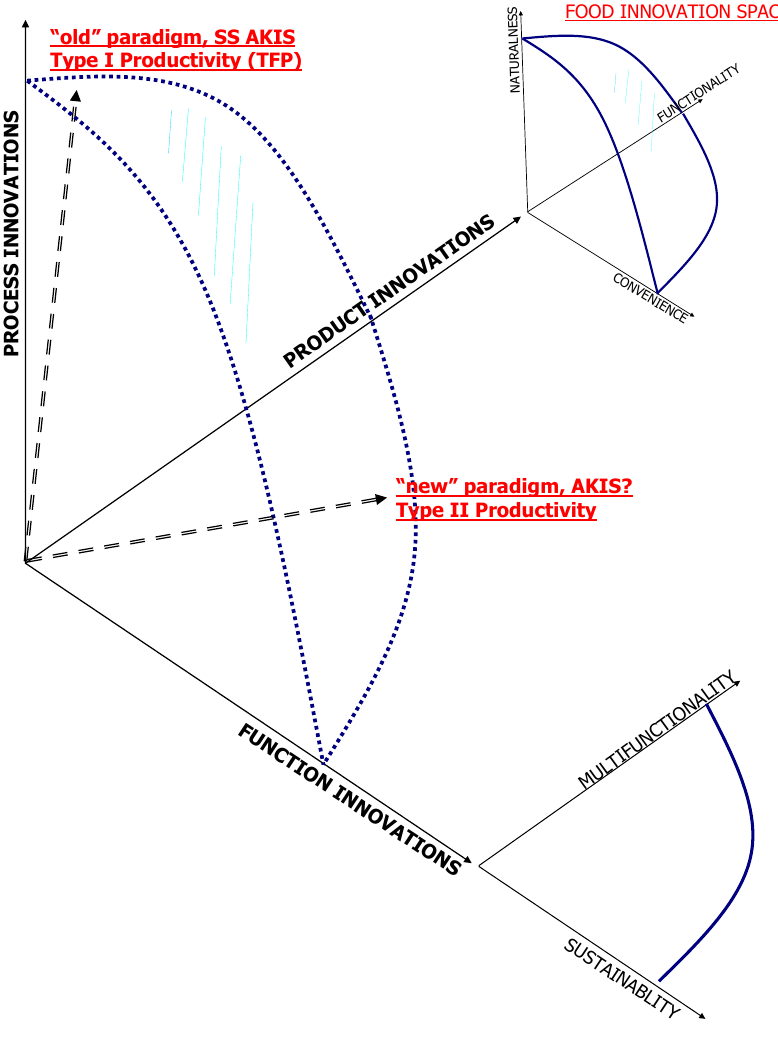
Figure 1. The Agricultural Innovation